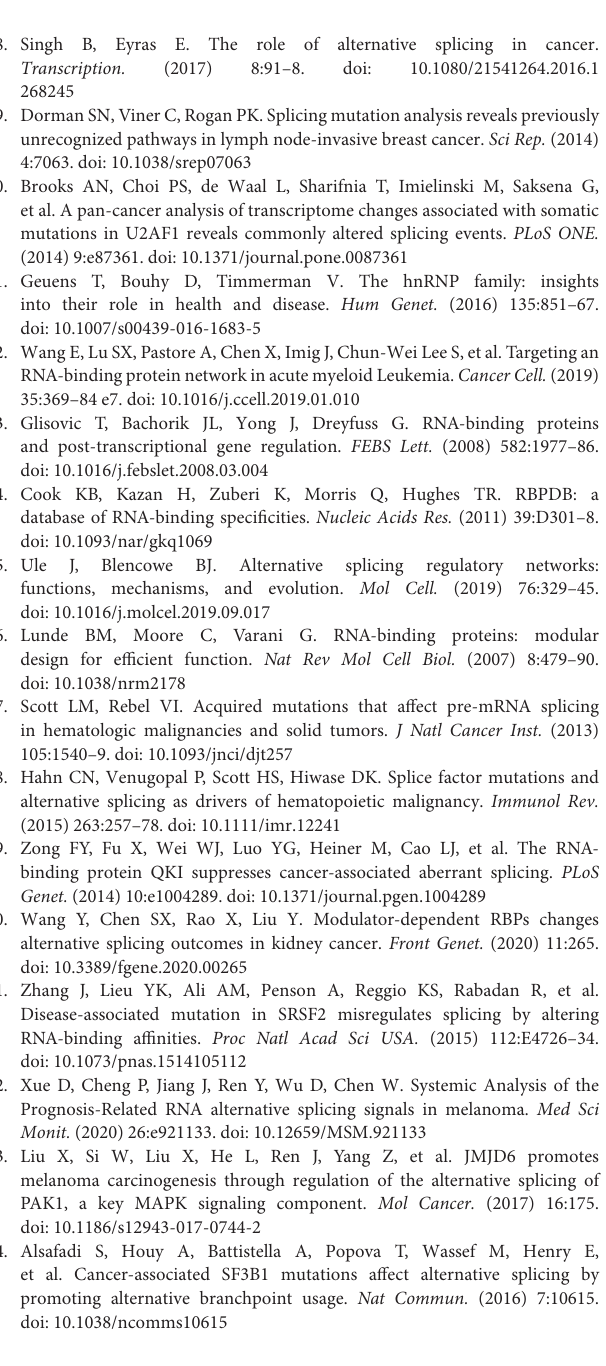
in the left table. The occurrence frequency of each types of splicing event and their parent genes were listed in the right table. Supplementary Table 7 | Construction of predict model based on RBP mutations. RBP mutations were selected by Lasso regression. A total of 13 RBPs were selected into the predict model using multivariate Cox regression analysis. The coefficient (Coef), hazard ratio (HR), 95% confidence interval (95%CI_L and 95%CI_H, respectively) and p -value were